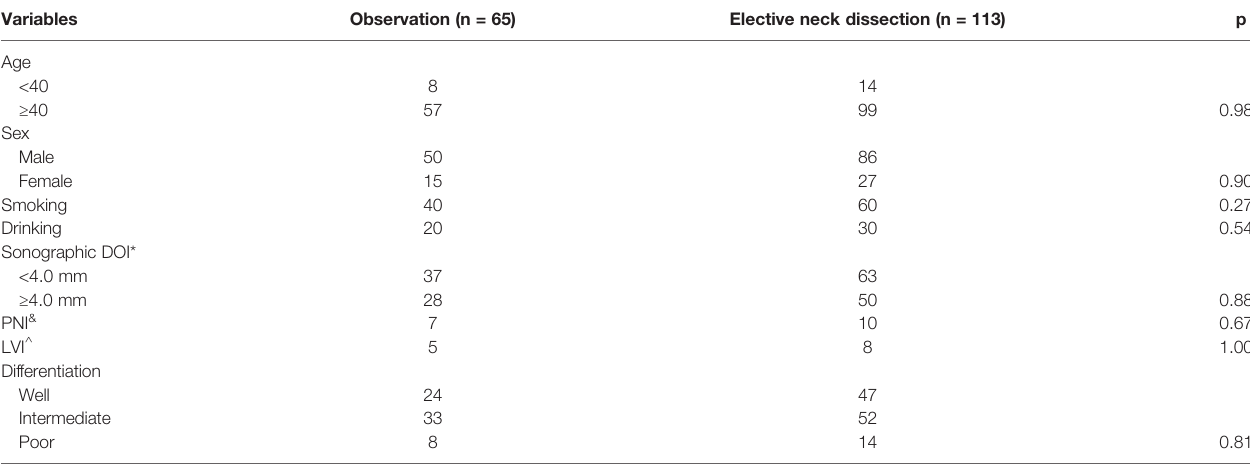
*DOI, depth of invasion. & PNI, perineural invasion. ^LVI, lymphovascular